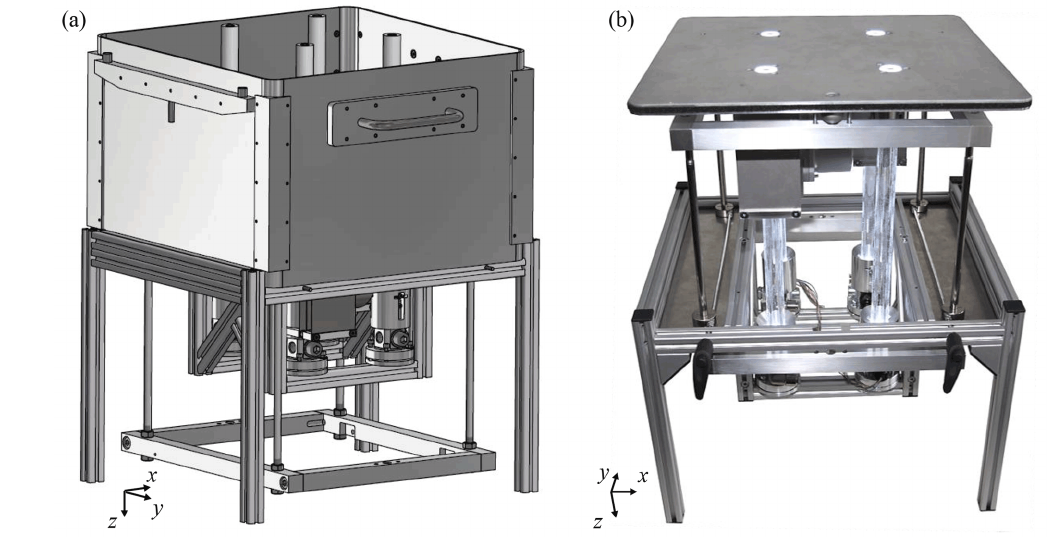
Figure 2. Extended EOS P380 powder box: (a) the CAD figure and (b) the real powder box body (without housing) with raised building plate and illuminated reference pipes.